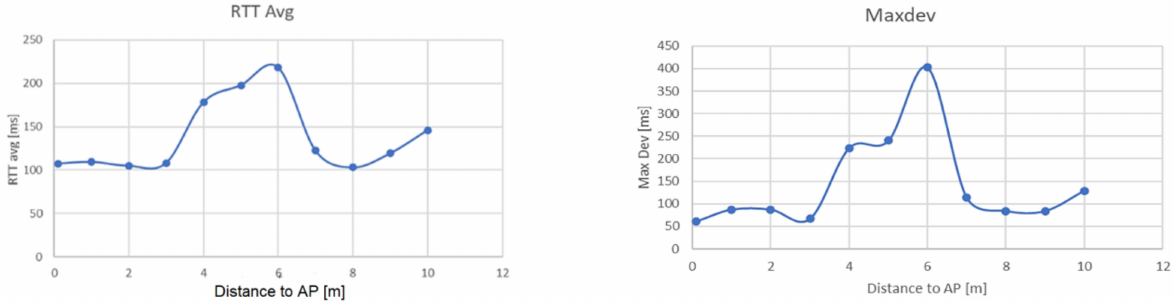
Figure 18. Variation of RTT ( left ) and Maximum deviation of recorded RTT ( right ) according to distance to AP, indoor, mixed path (0–8m LoS, 8–12m